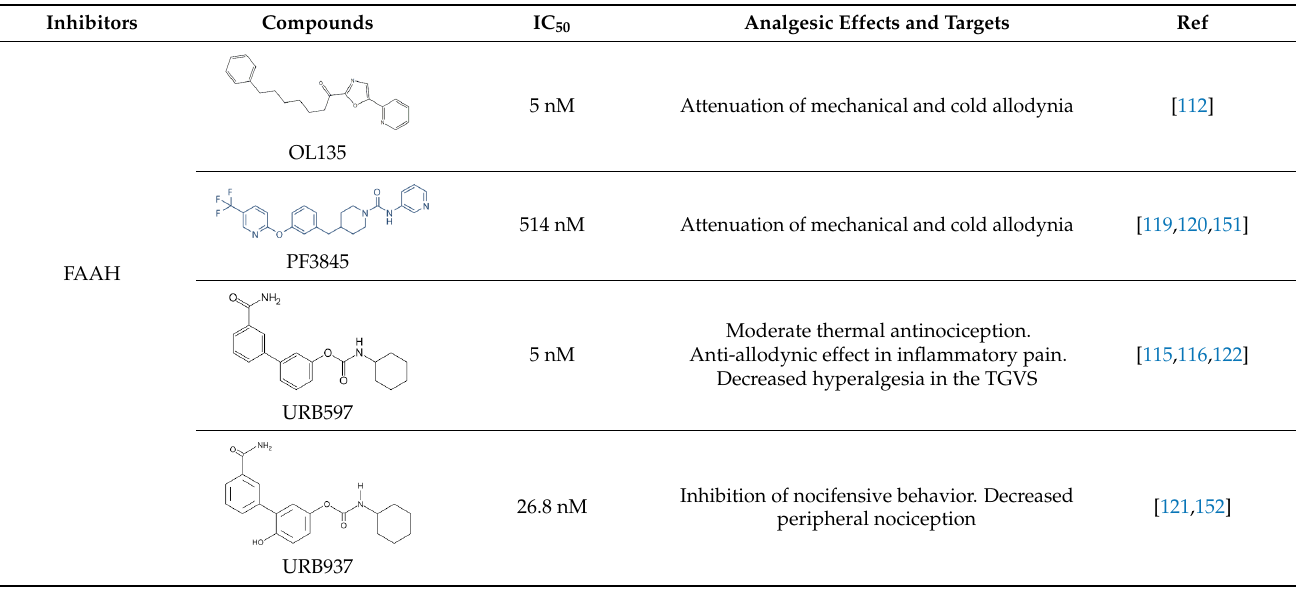
Table 1. Activity of MAGL and FAAH inhibitors tested for their analgesic effects.